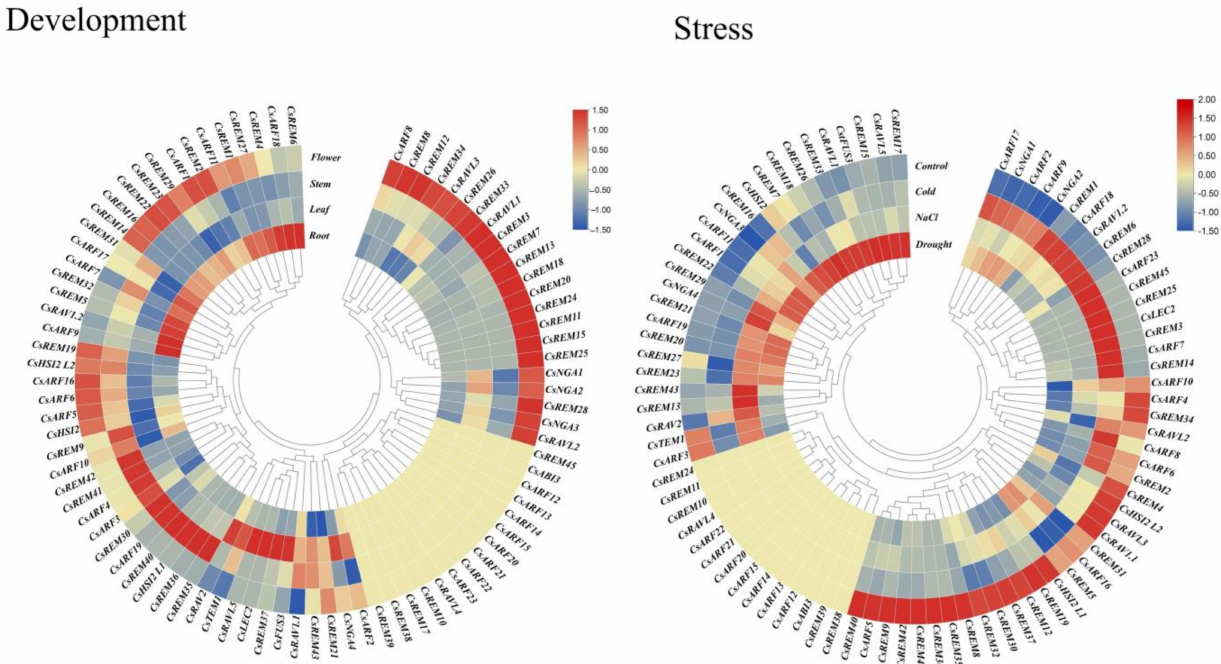
Figure 5. This diagram represents all the B3 genes in C. sativa and their respective in silico expression. On the left panel is the expression profile for the development of tissues such as flower, stem, leaf, and root, and on the right panel is the expression profile for different stresses such as cold, salt, and drought stress.